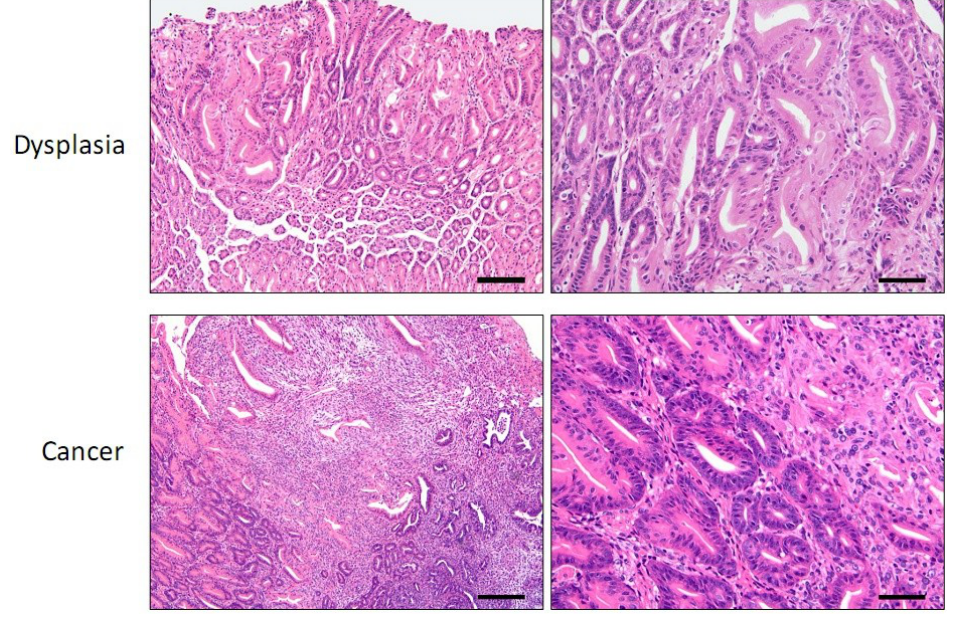
Figure 1. MNU-induced mouse tumor. Top panels: Low and high magnification images of the distal corpus showing gastric dysplasia (glandular proliferation with architectural distortion and cytological atypia in the superficial half of the mucosa) associated with oxyntic loss and pyloric-type glandular metaplasia. (Bar: Left 200× or 80 μM, Right 400× or 40 μM) Bottom panels: Low and high magnification images of a gastric tumor biopsy specimen showing dysplastic glands with lamina propria invasion, effacement and associated desmoplasia and inflammation. (Bar: Left 100× or 160 μM, Right 400× or 40